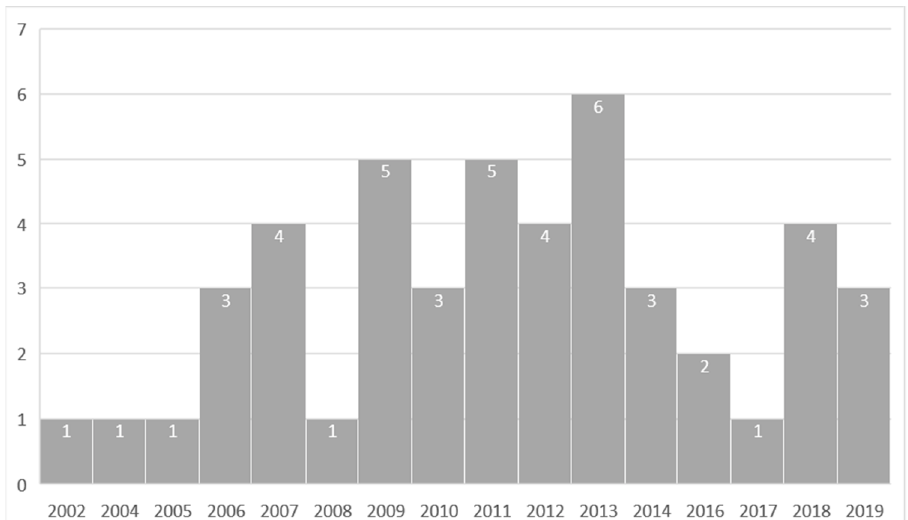
Figure 6. Articles by Year (final set).